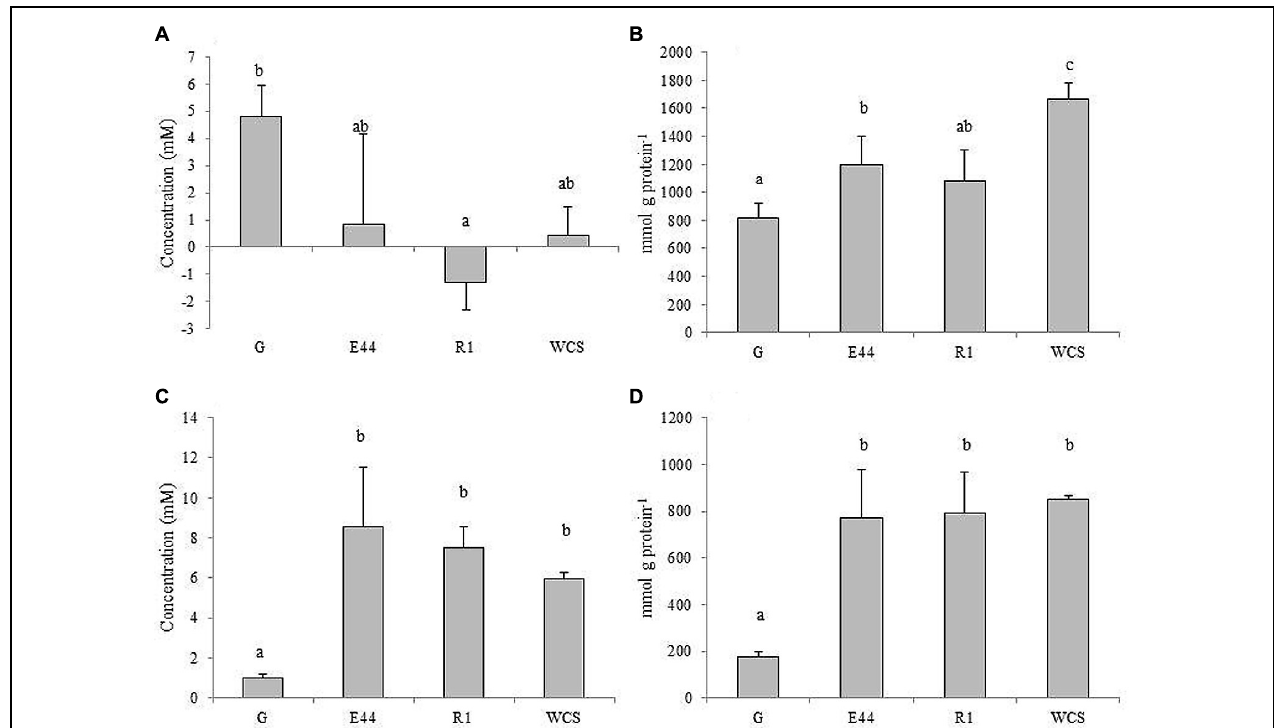
in medium without carbohydrate source (WCS). Different letters indicate significant differences among cultures with the different